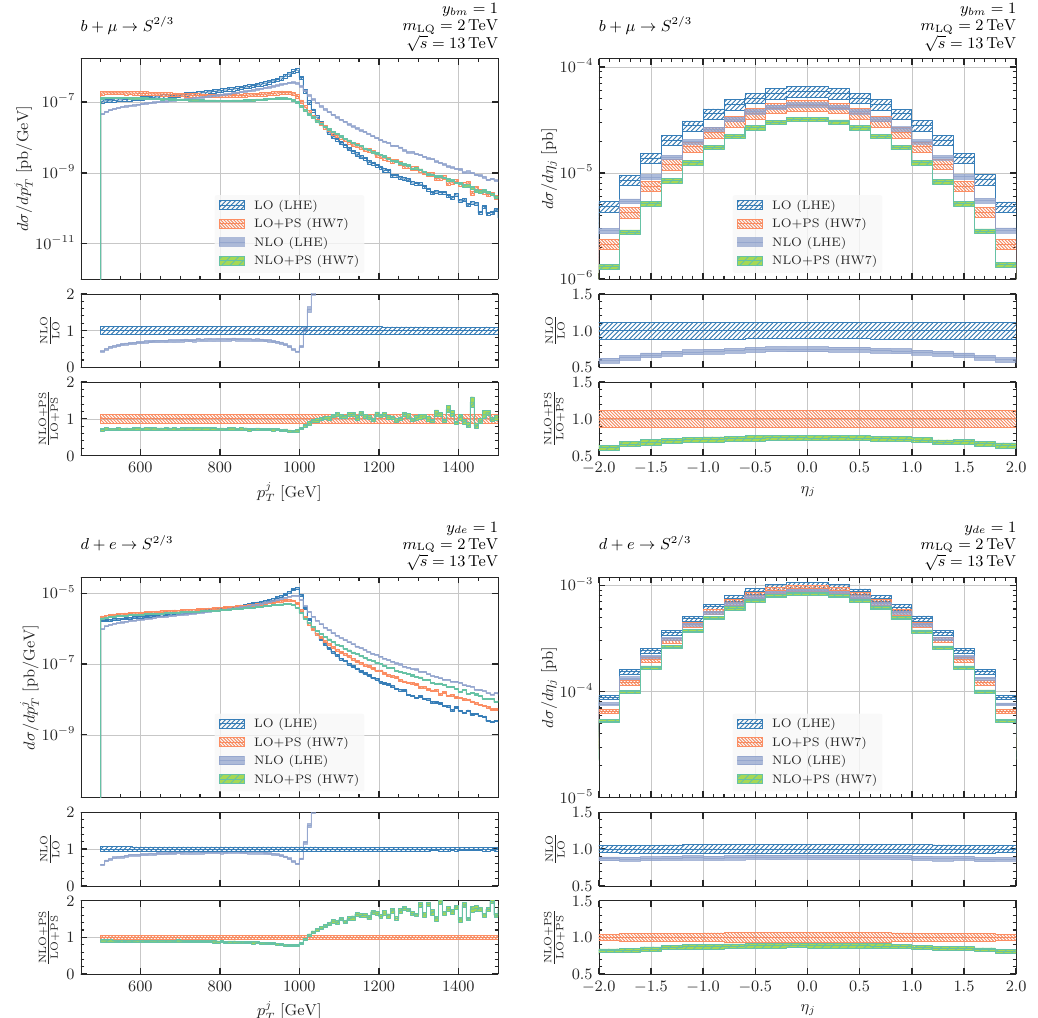
Figure 4 . The transverse momentum (left column) and the pseudorapidity (right column) distri- butions of the leading- p jet. See section 3.2 for T